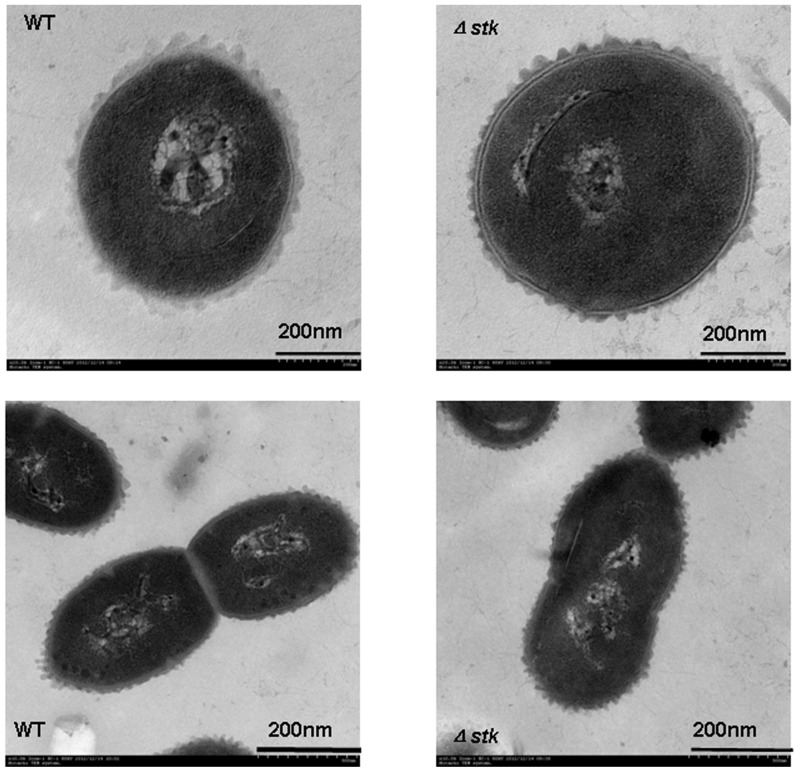
Transmission electron microscopy of SS2-1 and Δstk.The bar indicates the magnification size.